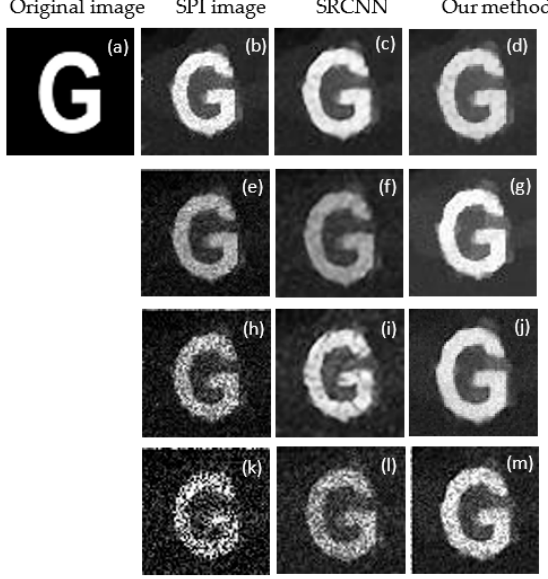
Figure 5. Image reconstruction results at different turbidities using random patterns in clear water under 300 measurements: ( a ) original image; ( b – d ) single-pixel imaging (SPI) image, SRCNN image, and our method image with 0 NTU; ( e – f ) SPI image, SRCNN image, and our method image with 20 NTU; ( d ) SPI image, SRCNN image, and our method image with 40 NTU; and ( k – m ) SPI image, SRCNN image, and our method image with 60